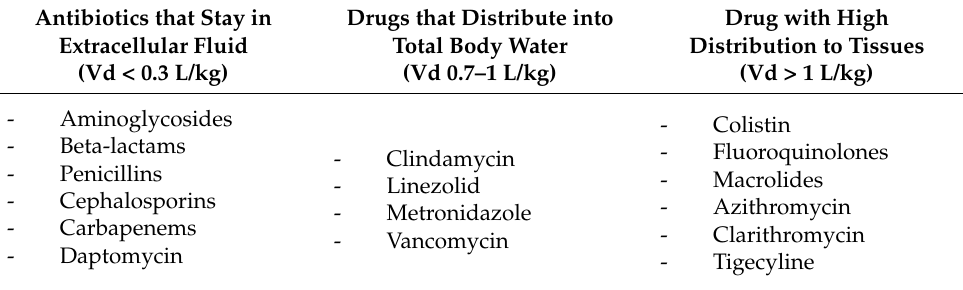
Table 1. Volume of distribution of ICU